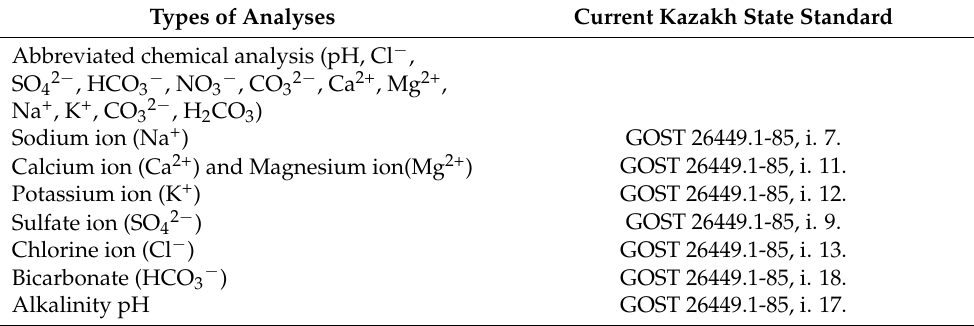
Table 1. Types of analyses and current standards for determining the chemical composition of natural waters (surface and groundwater) in the Republic of Kazakhstan.